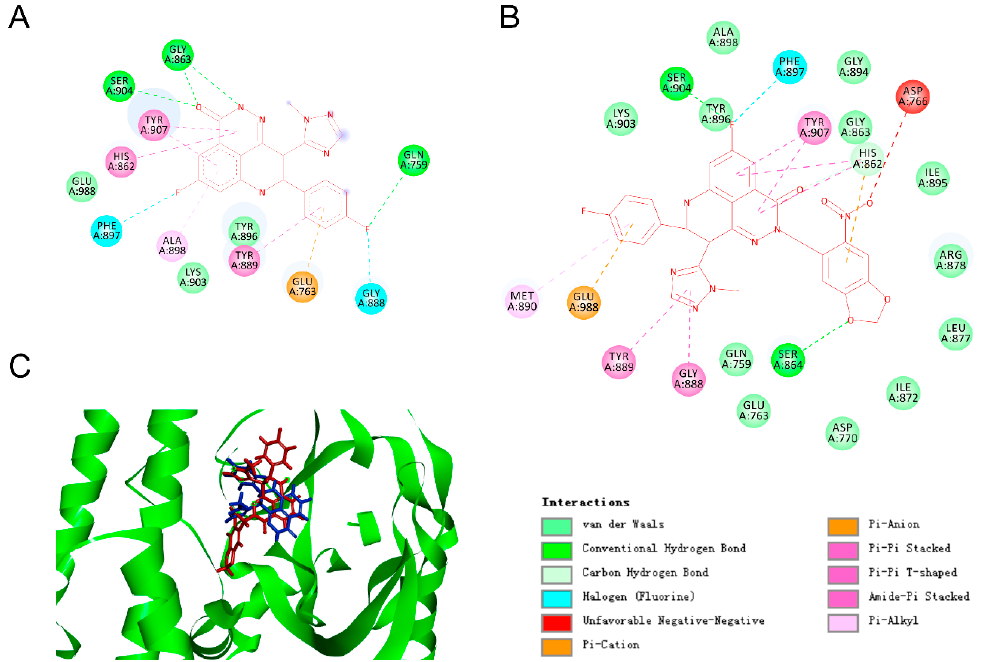
Figure 2. Predicted ligand binding models relative to the catalytic domain of poly (ADP-ribose) polymerase 1 (catPARP-1). ( A ) The co-crystallized binding modes of Talazoparib and the catPARP-1 protein were taken from PDB ID 4PJT. ( B ) Predicted co-crystallized binding poses of compound 3 in a complex with catPARP-1. ( C ) Superimposition of the binding models of Tazaloparib (blue) and compound 3 (red) with catPARP-1 protein